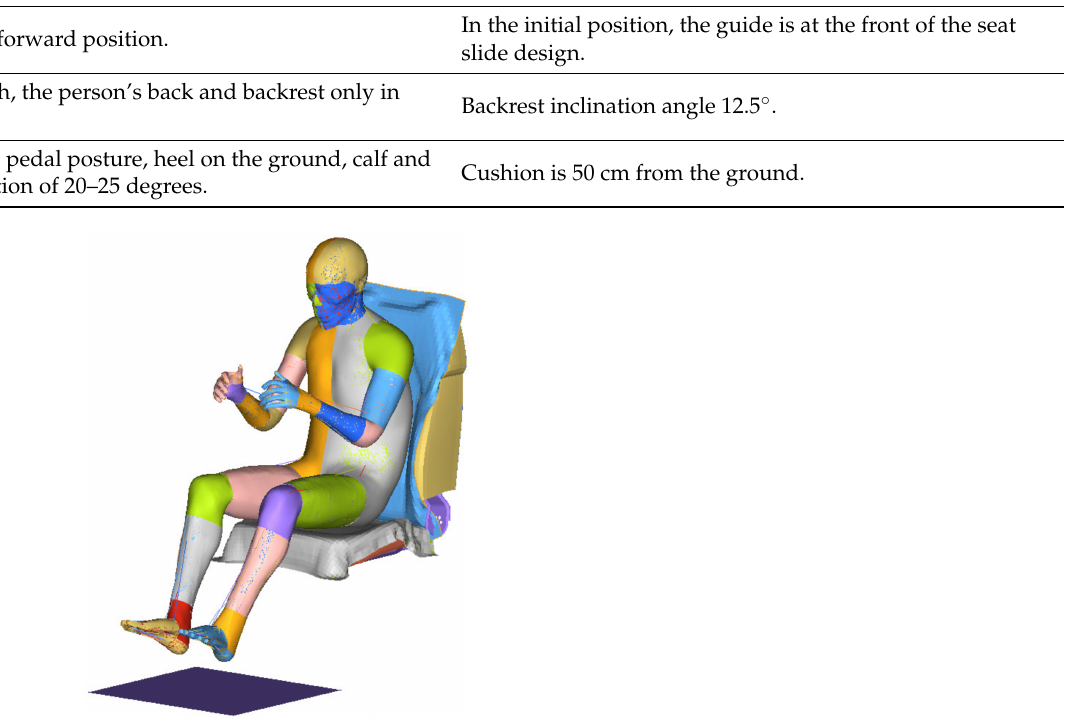
Table 2. Simulation and test posture of human-seat coupling system. Human